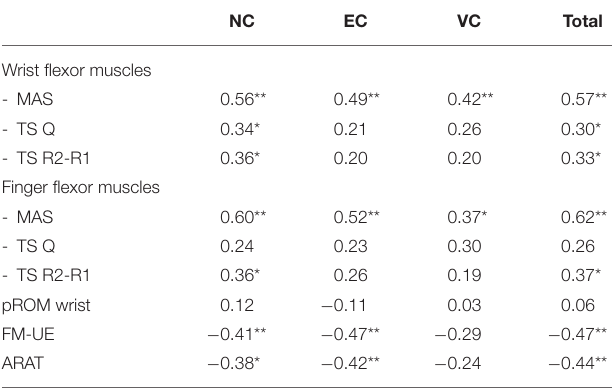
TABLE 4 | Spearman’s rank correlation coefficients ( r s ) between neural and non-neural components of wrist hyper-resistance and clinical